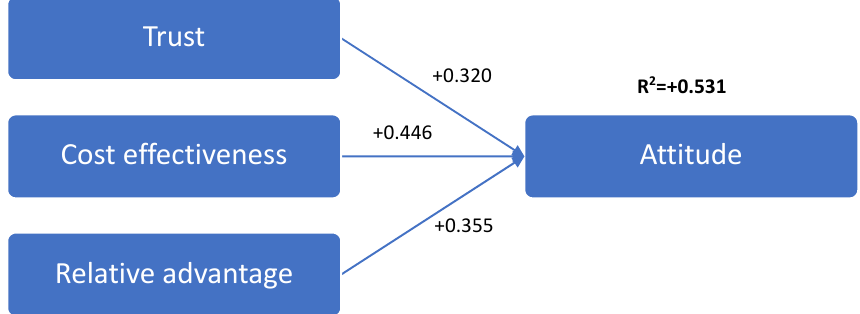
Figure 8. Regression model with coefficients for variables in Model 1.